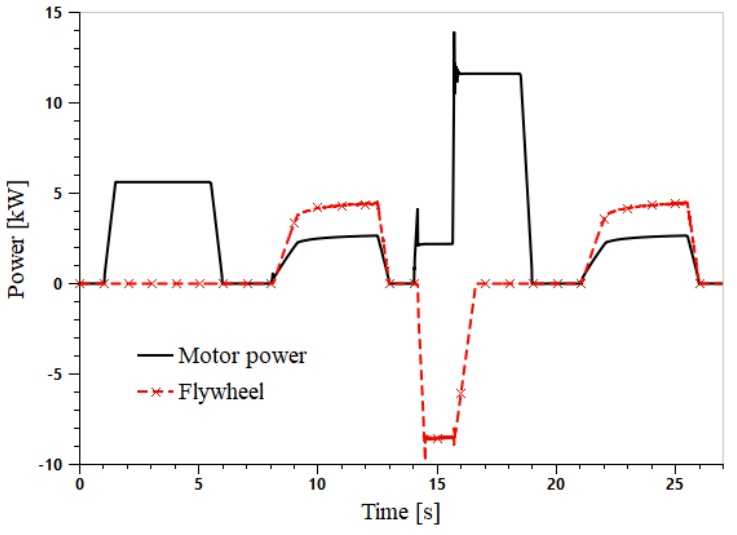
Figure 23. Power curves of the motor and flywheel when the excavator bucket is fully loaded.